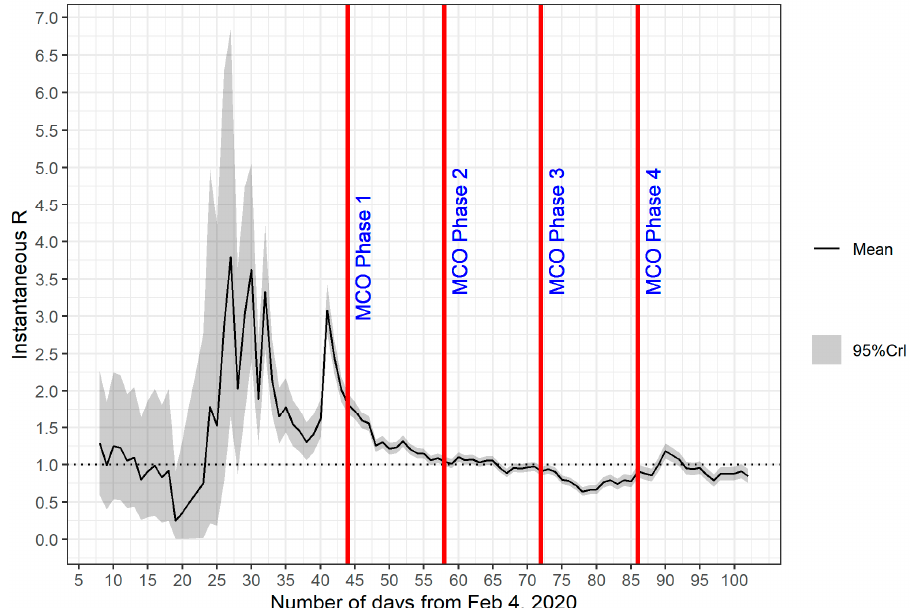
Figure 3. Rt from day 1 (4 February 2020) to day 102 (16 May 2020) on sliding weekly windows. The estimate was based on the serial interval with mean = 7.5 days and SD = 3.4 days.